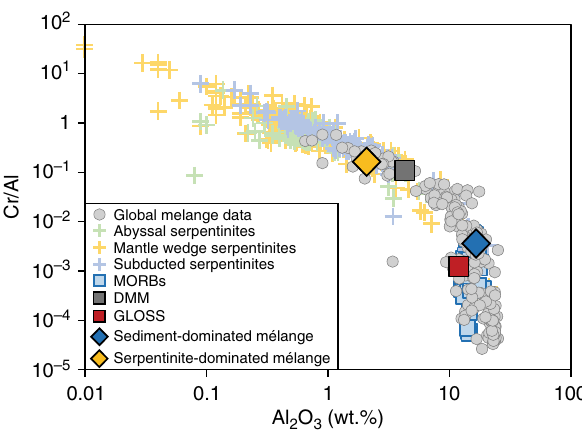
Fig. 2 Global variability of mélange rocks plotted in terms of immobile elements, Cr/Al versus Al 2 O 3 . The two types of mélange matrices used in this study cover a large range of the natural variability of mélanges, with one matrix that carries a serpentinite/ultrama fi c fl avor, and one matrix that carries a sediment (GLOSS) fl avor. Literature data sources: Global mélange compilation 23 , abyssal, mantle wedge and subducted serpentinite compilation 81 , MORB compilation 58 , DMM composition 66 , and GLOSS